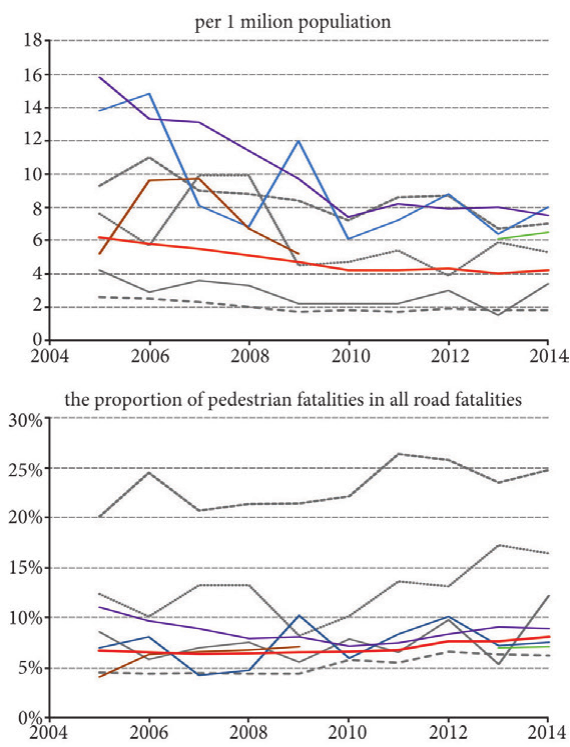
Fig. 3. Cyclist fatalities according to the data of 2016 from the European Road Safety Observatory (ERSO